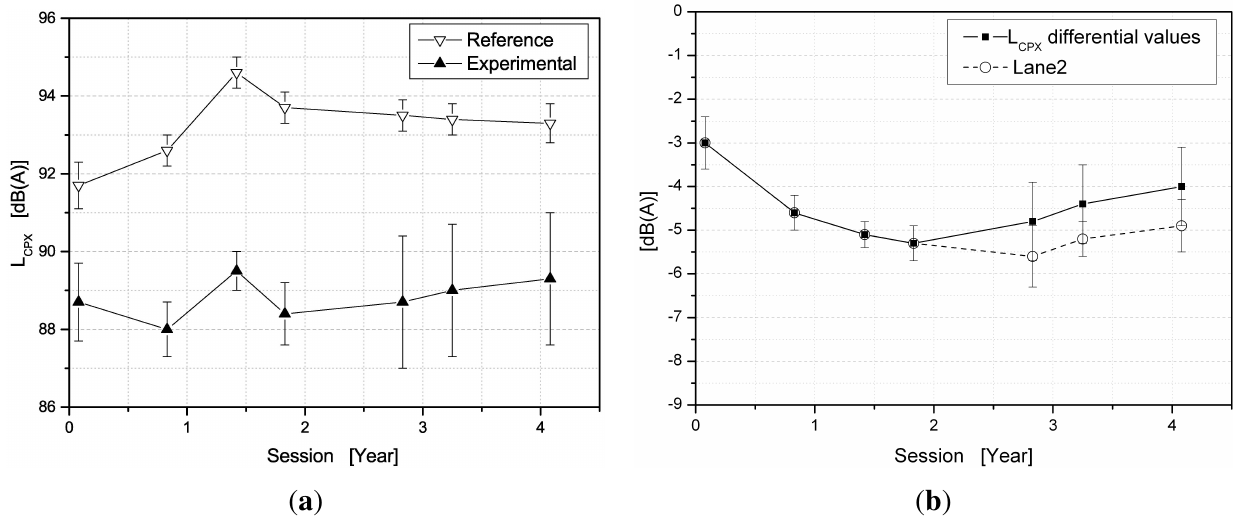
Figure 3. Absolute ( a ) and differential ( b ) values of L (e.g., time, in years) for the micro-draining surface laid in Site